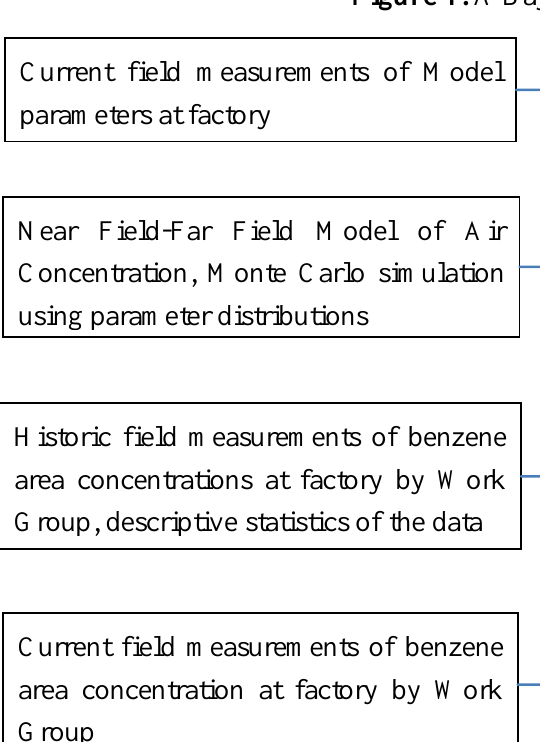
Figure 1. A Bayesian process